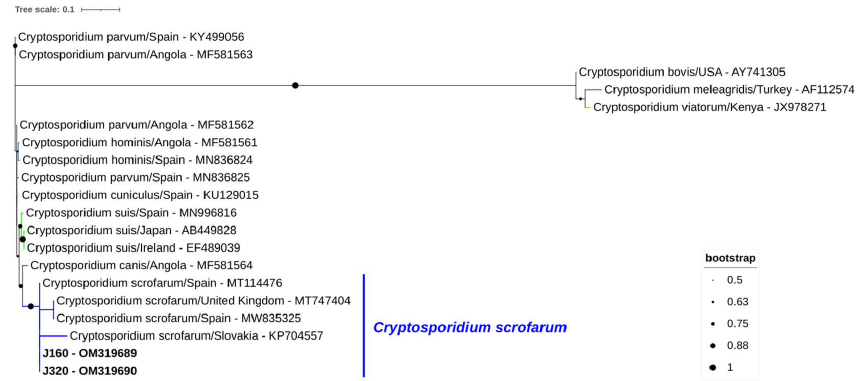
Figure 2. Phylogenetic analysis of Cryptosporidium found in wild boars. Tree inferred using the MEGA X maximum likelihood method (Tamura 3-parameter model) and the Interactive Tree of Life (iTOL) based on 20 nucleotide Cryptosporidium spp. sequences at the ssu rRNA marker, including sequences found in this study ( Cryptosporidium scrofarum , plus its accession number, is in bold) and 18 strains of different Cryptosporidium species obtained from GenBank (no bold or shading and identified with the accession number and its species and country of origin). Twenty-one samples tested positive for B. coli (14.6%, 95% CI: 9.2–21.4). Six samples generated sequences showing 95–100% identity with a B. coli isolate from a pig in South Korea (MZ676851); two shared 99.6% and 98.8% identity, respectively, with a B. coli isolate also from a South Korean pig (MZ676842), one sequence shared 100% identity with a B.